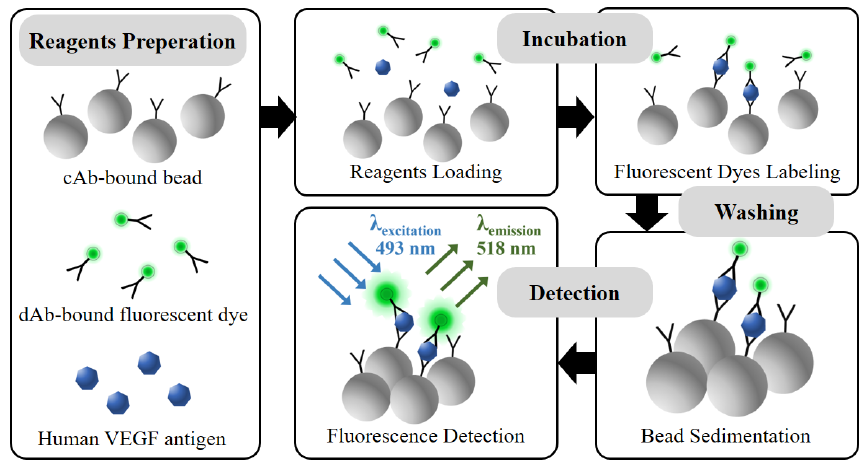
Figure 2. Schematic of the VEGF detection process via simplified microbead FLISA protocol. Biological assay between reagents is performed together in incubation step. The unbound dAb-fluorescent dye is eliminated in washing step. The fluorescence signal is measured for VEGF detection as much as the fluorescent dye attached to the microbead.